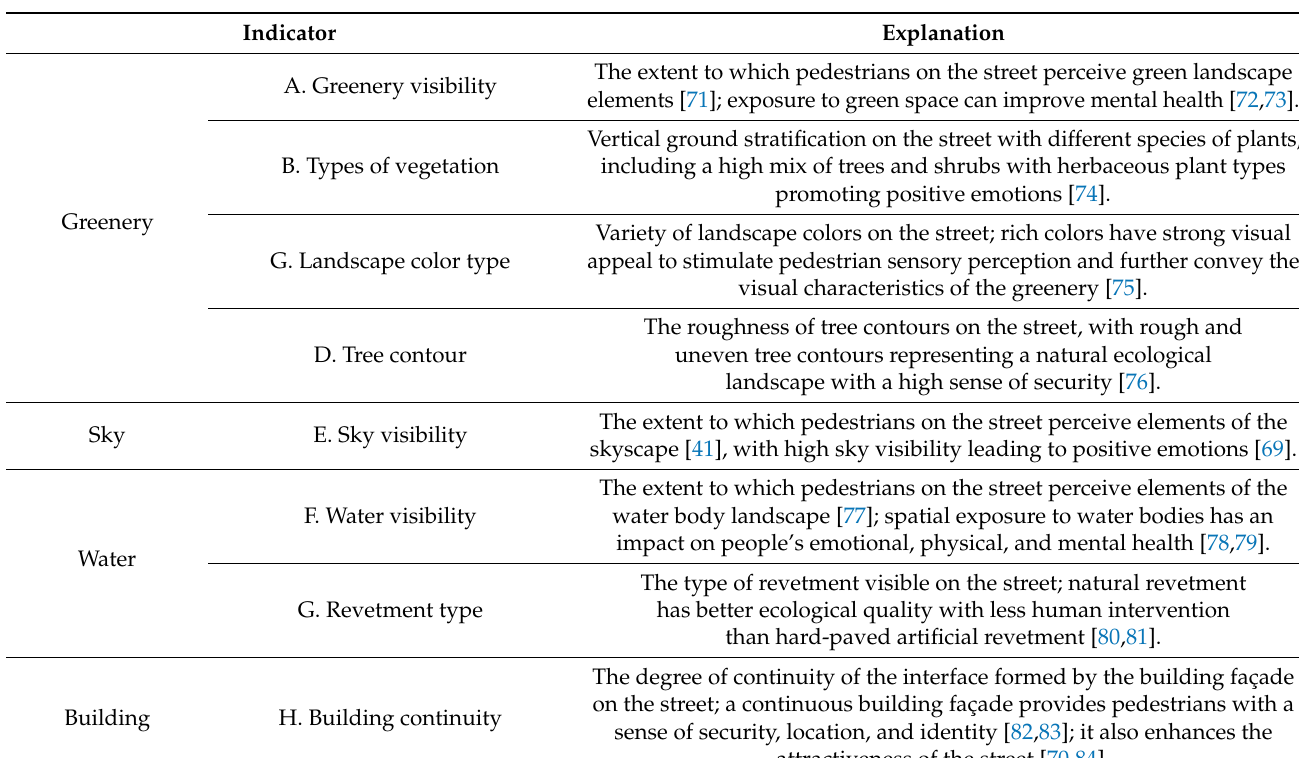
Table 3. Evaluation system for space quality of the lakefront